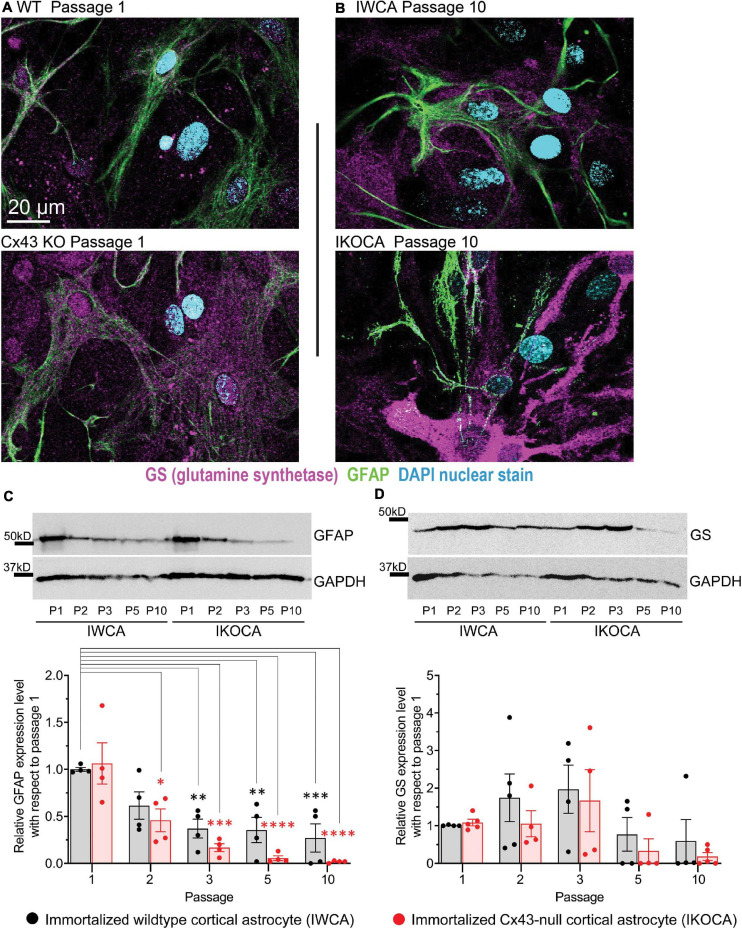
Expression level and localization of GFAP and GS in IWCA and IKOCA during the first ten passages. (A,B) GFAP immunostaining declined with time in culture for both IWCA and IKOCA. GS was highly expressed in both IWCA and IKOCA cultures at all passages but declined at passage 5 in both genotypes. Scale bar is 20 μm and scale is the same for all microscope images in this figure. (C) GFAP protein levels also declined rapidly with progressive passage, with minimal levels of about 27% in IWCA and about 2% in IKOCA cultures. (D) GS protein levels increased over time in culture, being somewhat variable at all-time points.